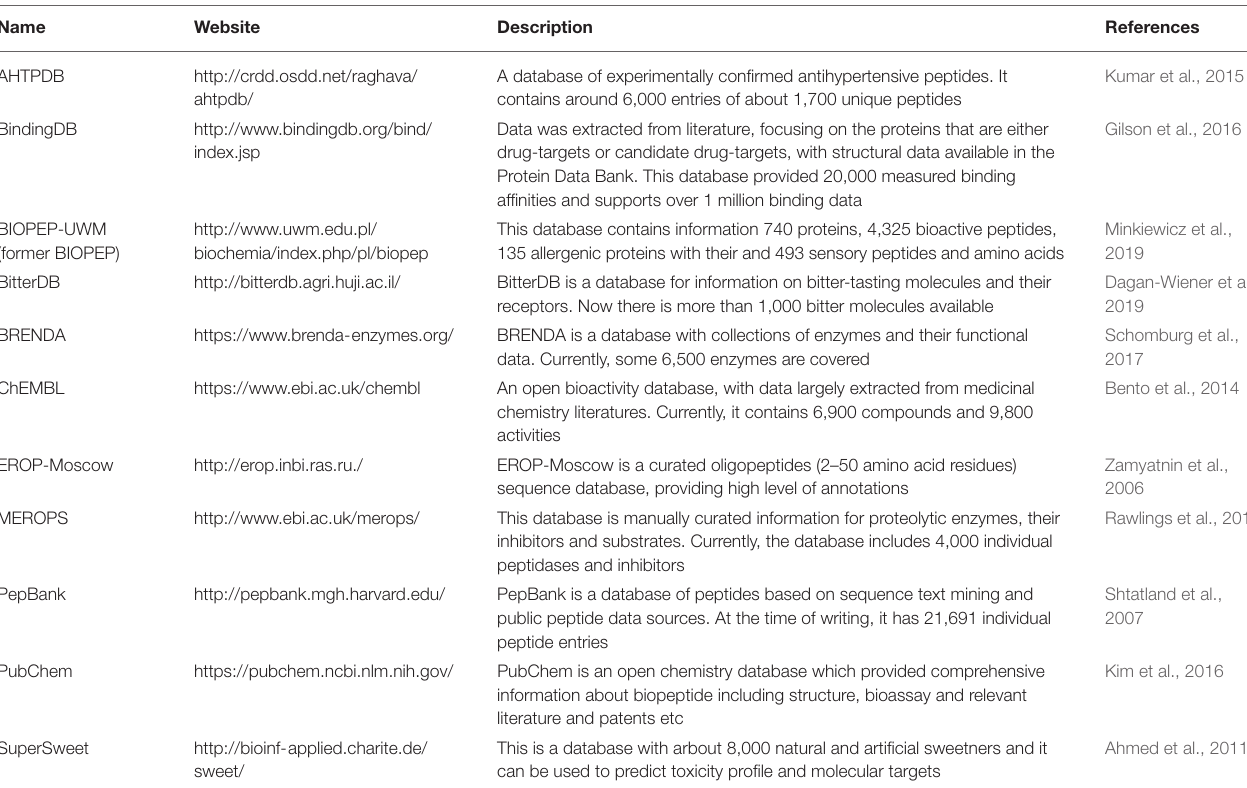
TABLE 5 | Biopeptide database available online (accessed in July,